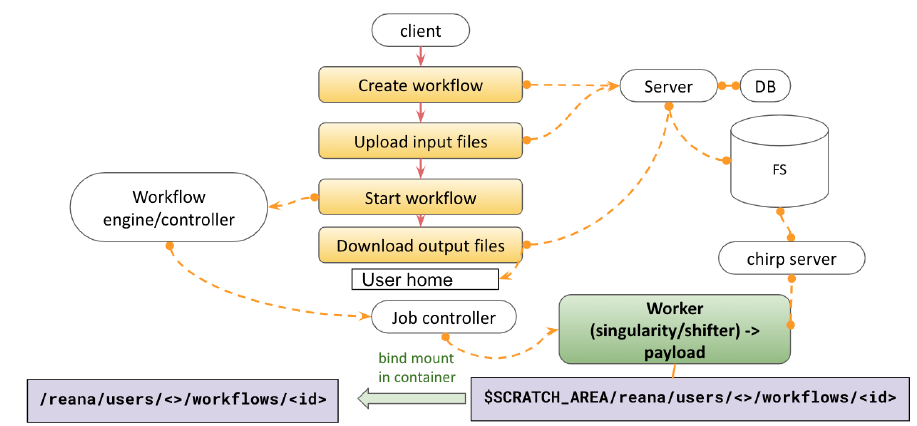
Figure 7. Schematic showing the REANA client creating and running new workflow, after integrating the detection and usage of HPC friendly container technologies and connecting the edge service file system used by REANA server via chirp and